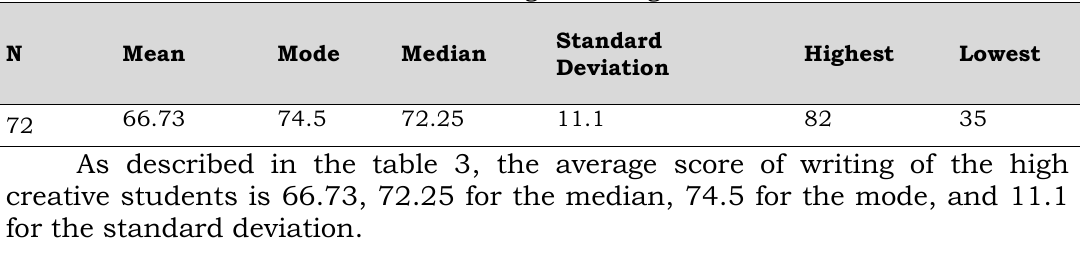
Table 3. The scores of writing of the high creative